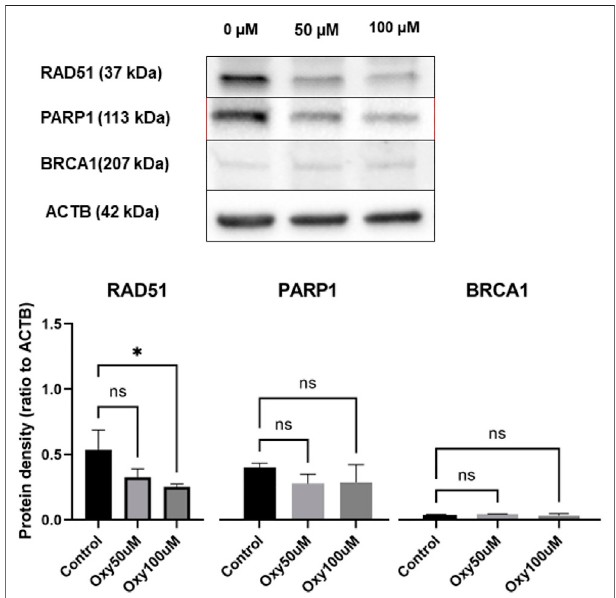
FIGURE 11 | Expression of DNA repair proteins in MCF-7 breast cancer cells treated for 24 h with 50 and 100 µM of OXY compared with untreated control. Total cell lysates were blotted and identi fi ed as described in the materials and methods section. Statisticalanalysiswascarried outusing One-way ANOVA analysis of variance followed by Dunnett ’ s test. The signi fi cant difference was compared relatively to control (* p (cid:2)